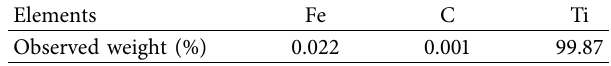
Table 1: Composition of base metal.